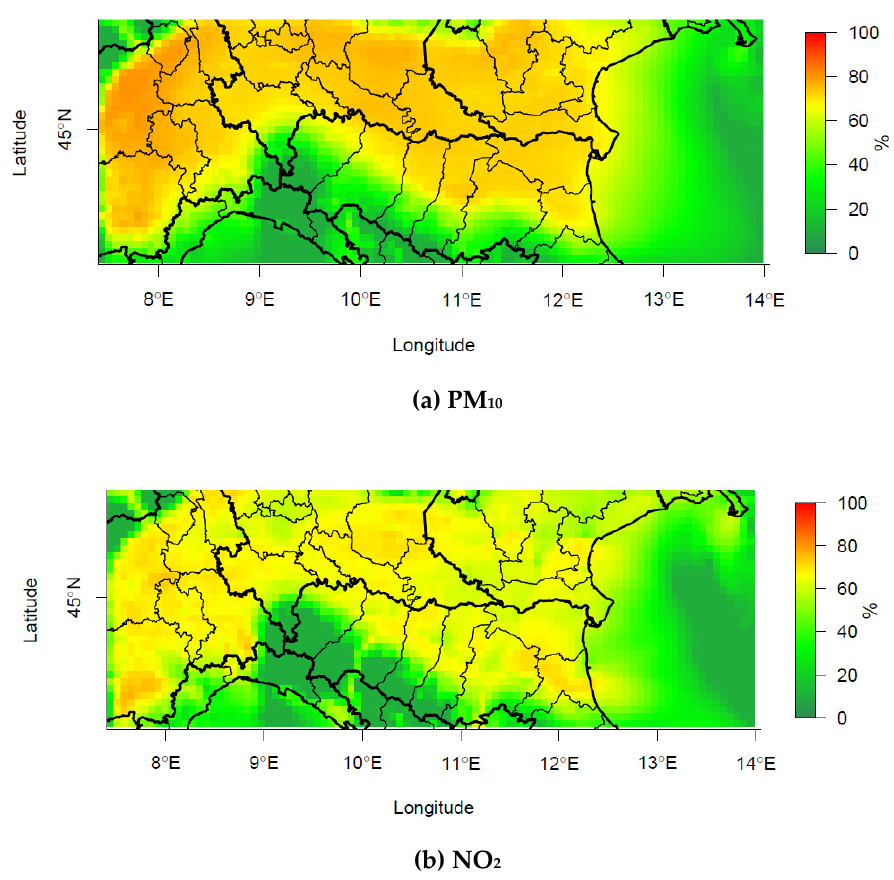
Figure 15. December 2018 ( a ) PM 10 reduction and ( b ) NO 2 Figure 15. December2018 ( a ) PM 10 reduction and ( b ) NO 2 reduction.